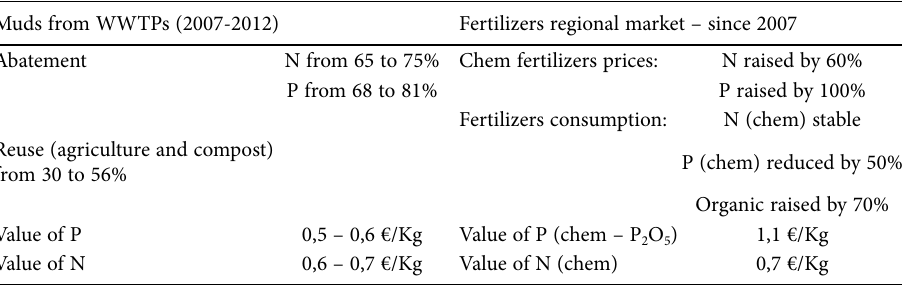
Table 6. Simulation of market price for WWTP muds relative to the title in P and N and market oppor- tunity Muds from WWTPs